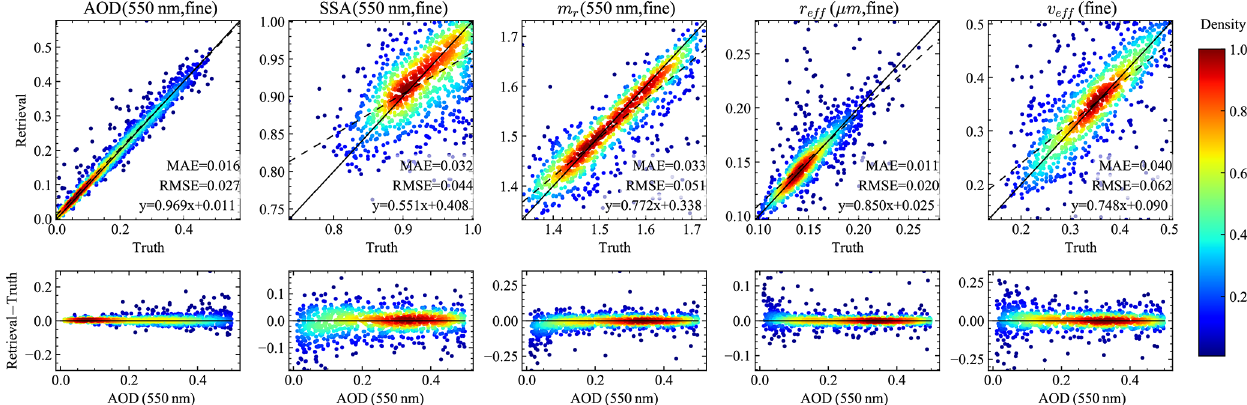
Figure 8. The comparisons of the retrieved and truth values for the fine-mode aerosol parameters including AOD, SSA, refractive index ( m r ), and effective radius ( r eff ) and variance ( v eff